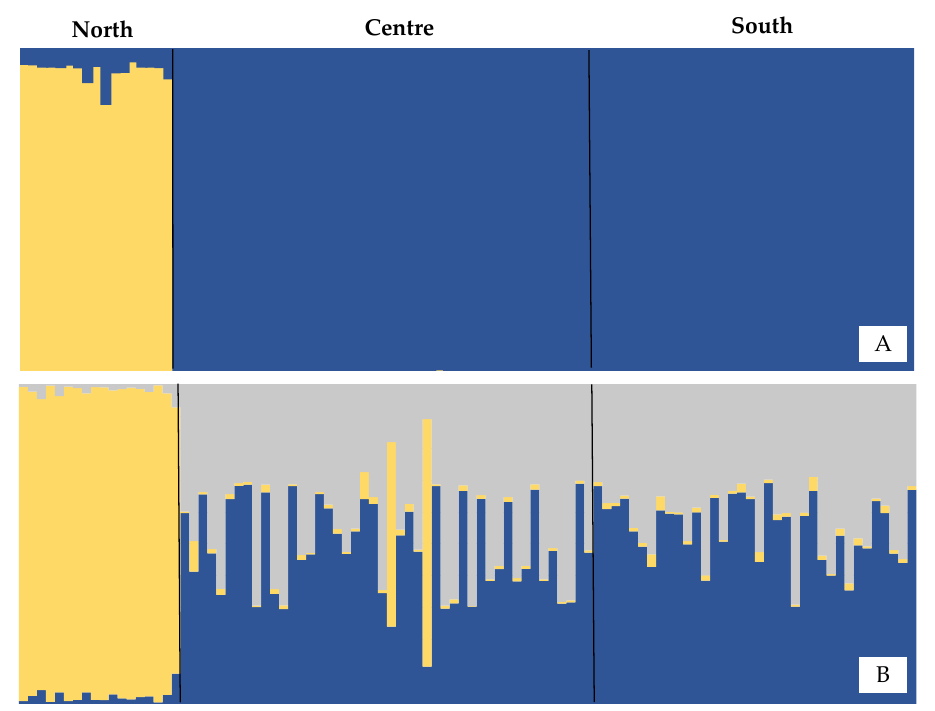
Figure 2. Q coefficient bar graph for each population, considering K = 2 ( A ) and K = 3 ( B ) population units for Micropogonias furnieri .